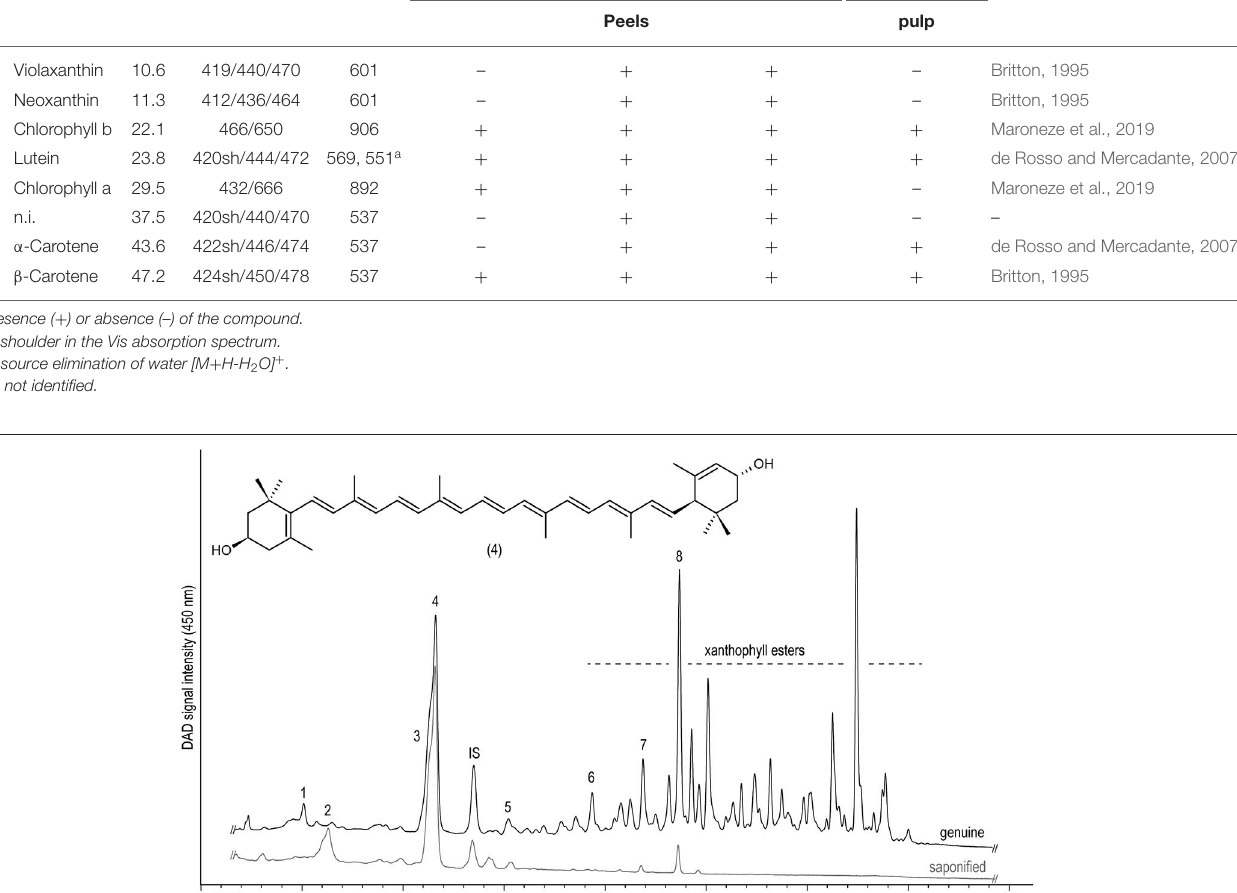
et al., 2003; de Castro and Marraccini, 2006). These primary photosynthetic pigments were identified in our work by their protonated molecules [M H] + at m/z 892 and 906, respectively, + to Maroneze et al. (2019). Table 5 compiles the criteria for identification of the remaining carotenoids and the corresponding